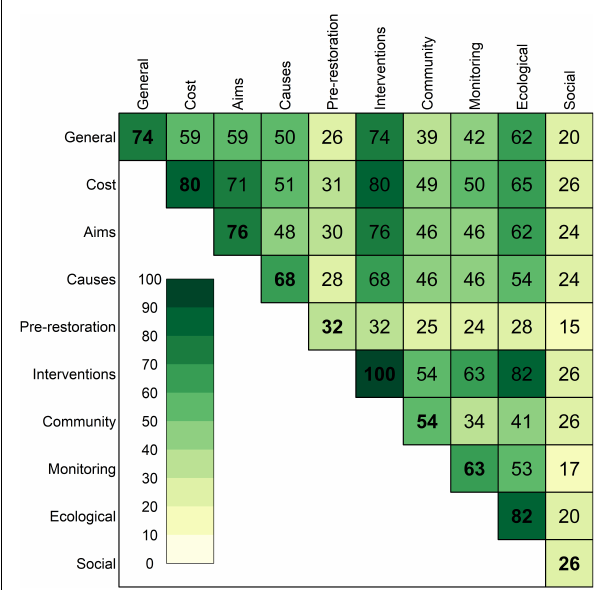
Frontiers in Forests and Global Change |